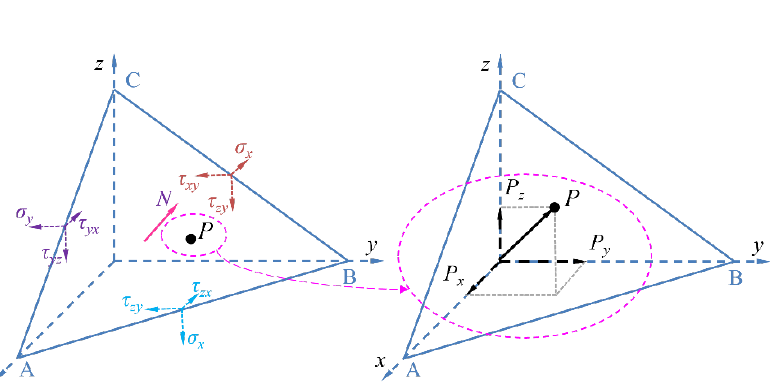
Figure 5. Stress components of the oblique section of the element Figure 5. stress components of the oblique section of the element body.